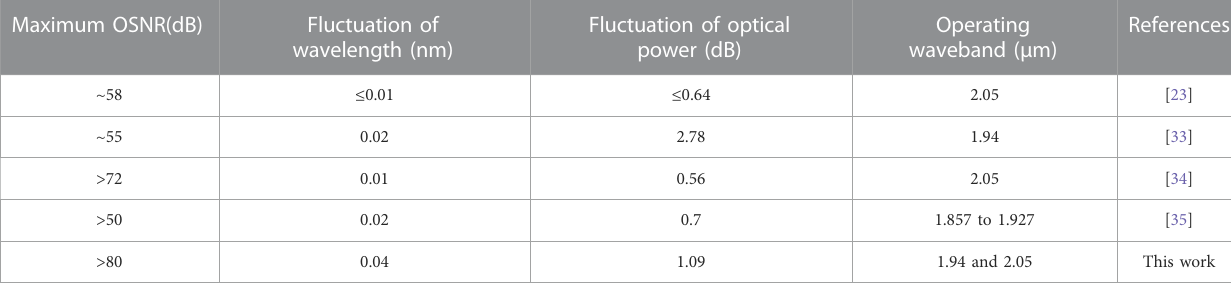
TABLE 1 Comparison of our TDFL with some of the reported wavelength switchable TDFLs based on